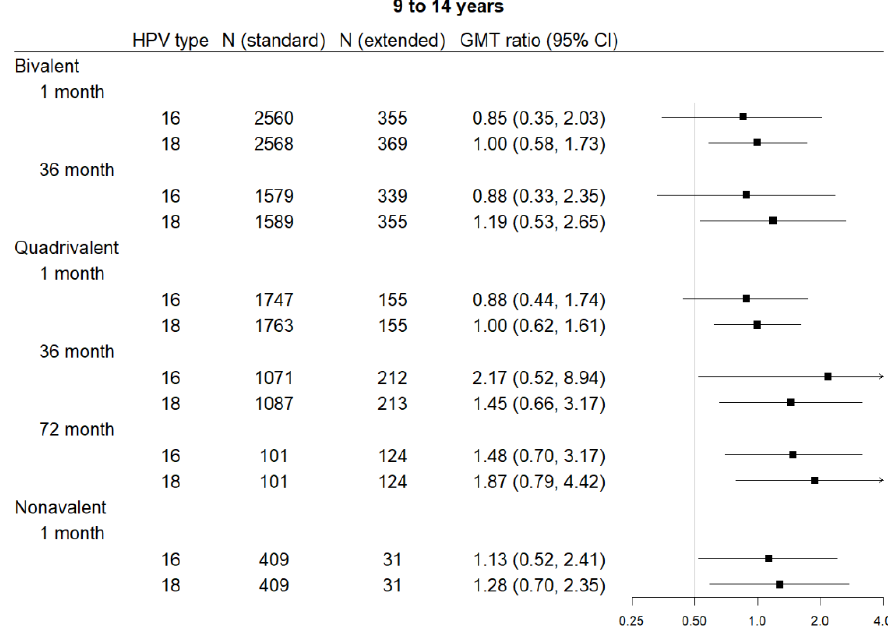
Figure 3. Forest plot of GMT ratio of extended interval versus standard schedule (with 0.5 indicating the non-inferiority cut-point—i.e., those with lower bounds greater than 0.5 are considered to meet non-inferiority criteria), by vaccine, human papilloma virus (HPV) subtype, time point, and age group.